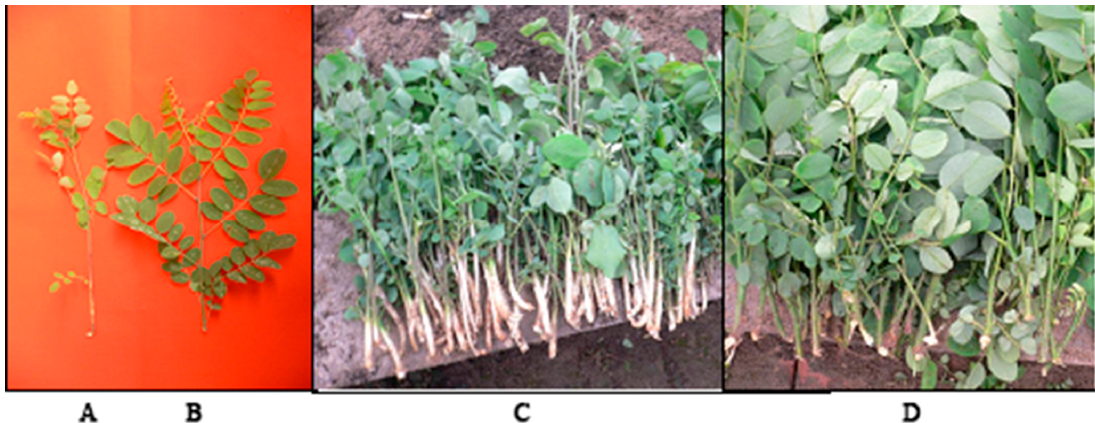
Figure 1. The photos of etiolated and non ‐ etiolated tetraploid Robinia pseudoacacia cuttings. ( A , C ) Etiolated tetraploid R. pseudoacacia ; ( B , D ) Non ‐ etiolated tetraploid R. pseudoacacia